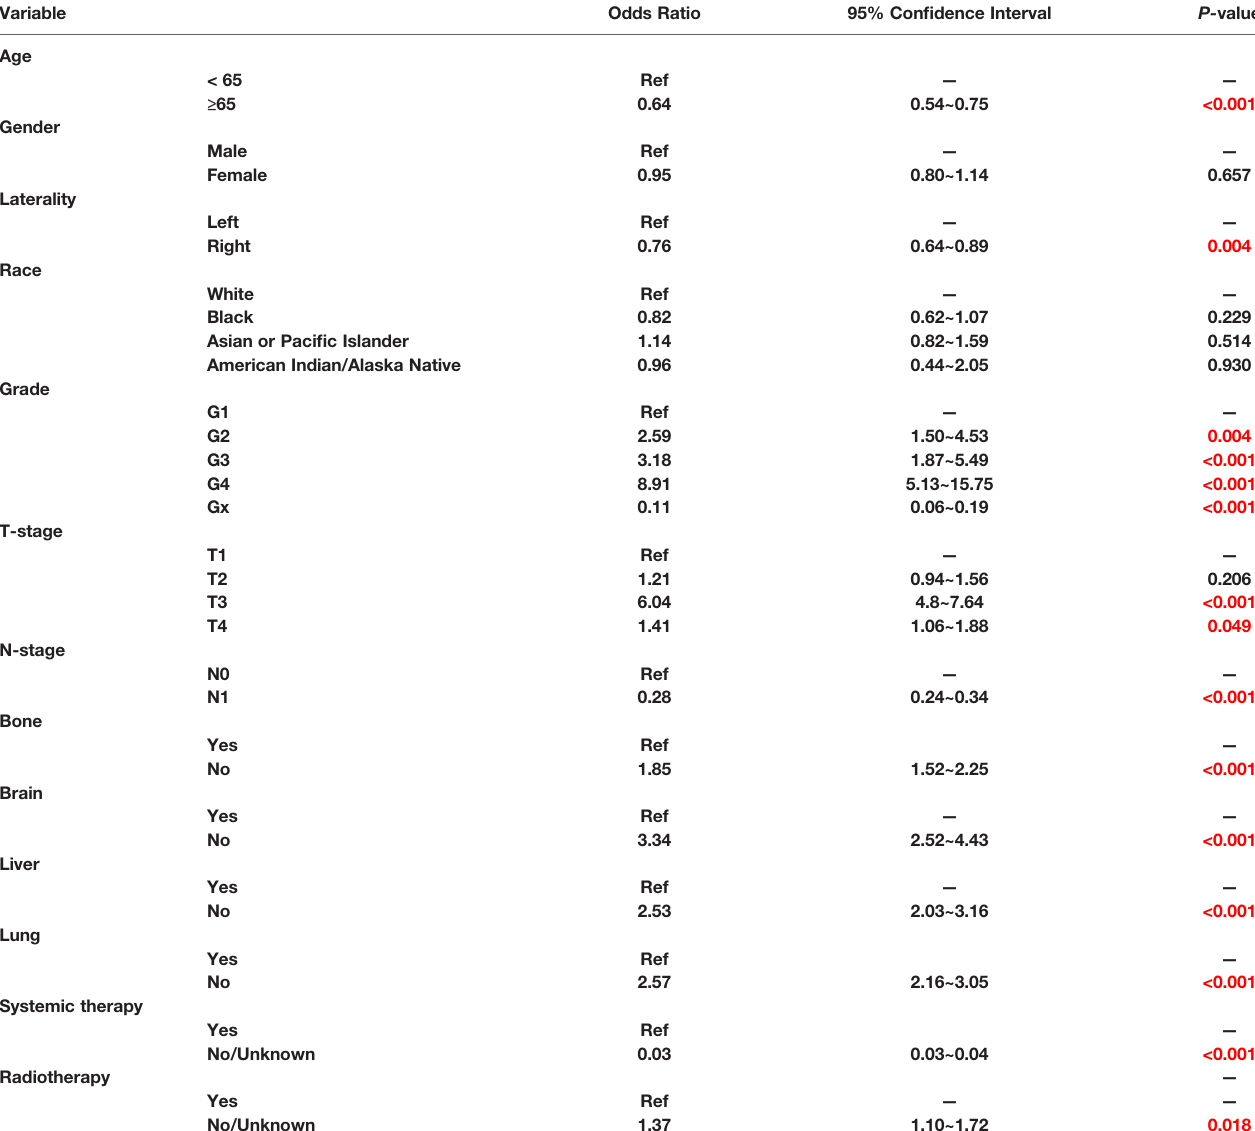
TABLE 1 | Multivariable logistic regression models predicting probability of CN recipients.